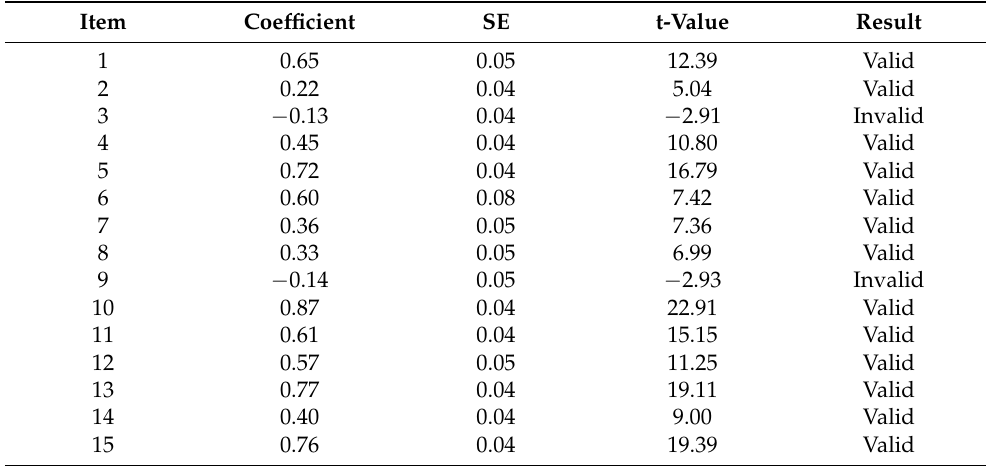
Table 2. Validity of religious moderation items.